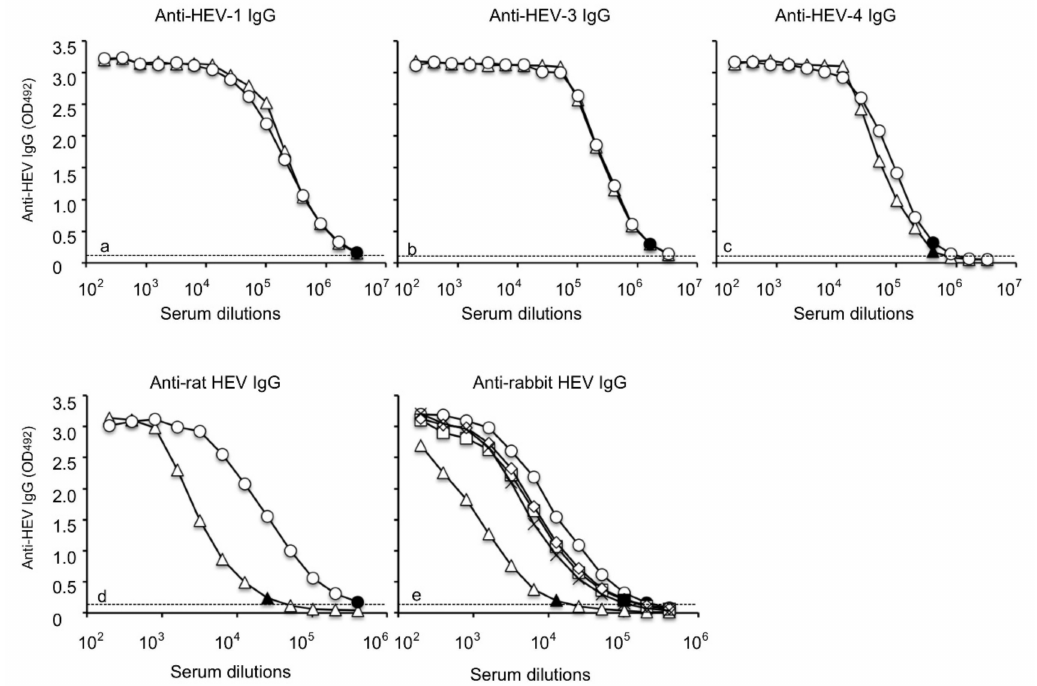
Figure 5. Antigenic cross-reactivity among HEV-1, HEV-3, HEV-4, rabbit HEV and rat HEV. The reactivity of anti-HEV-1 IgG to the homologous antigen HEV-1 VLPs ( ) and heterologous antigen rabbit HEV ( (cid:52) ) was examined by antibody ELISA ( a ). Similarly, the reactivity of anti-HEV-3 IgG ( b ), that of anti-HEV-4 IgG ( c ) and that of anti-rat HEV IgG ( d ) was examined. The reactivity of anti-rabbit HEV IgG was determined by an antibody ELISA using the heterologous VLPs of HEV-1 ( ), HEV-3 ( ), HEV-4 ( ) and rat HEV ( ) and was compared with that of homologous rabbit HEV VLPs (RsVLPs) ( ) ( e ). Dotted lines indicate the cut-off values. The black shapes indicate the endpoints of the IgG antibody titers.